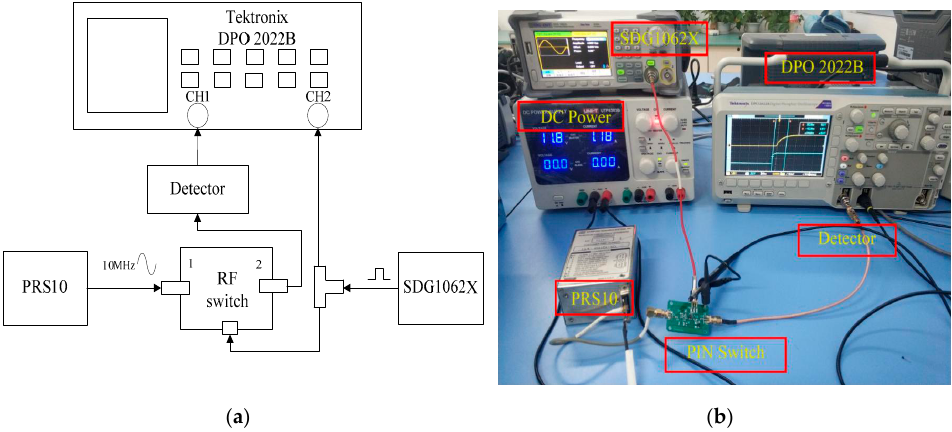
Figure 10. Platform for testing the switching speed of RF switches: ( a ) Block diagram of the experimental platform and ( b ) Photograph of the experimental platform.